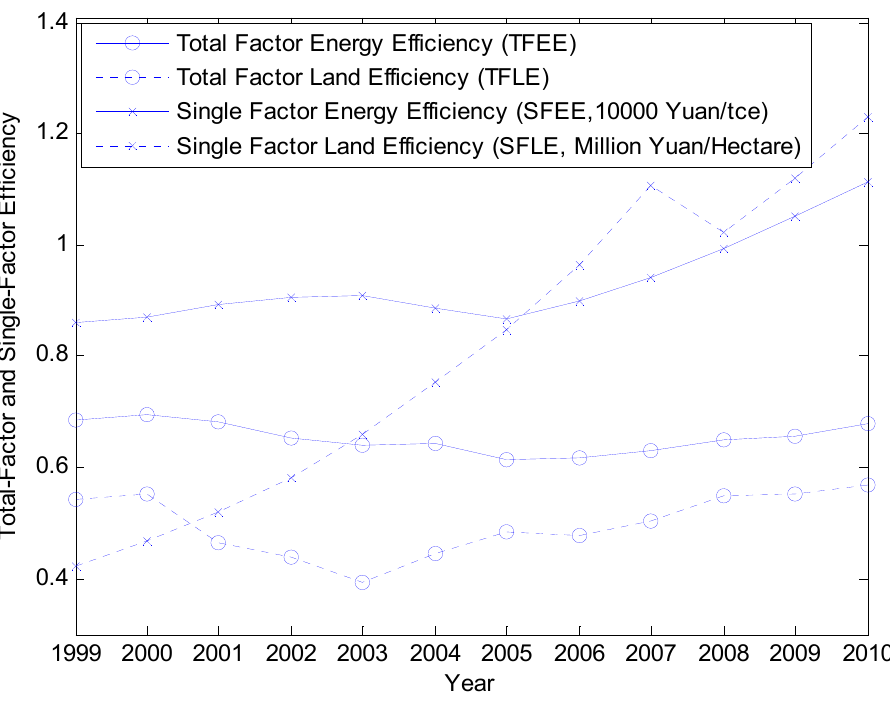
Figure 8. Comparison between total-factor and single-factor energy/land